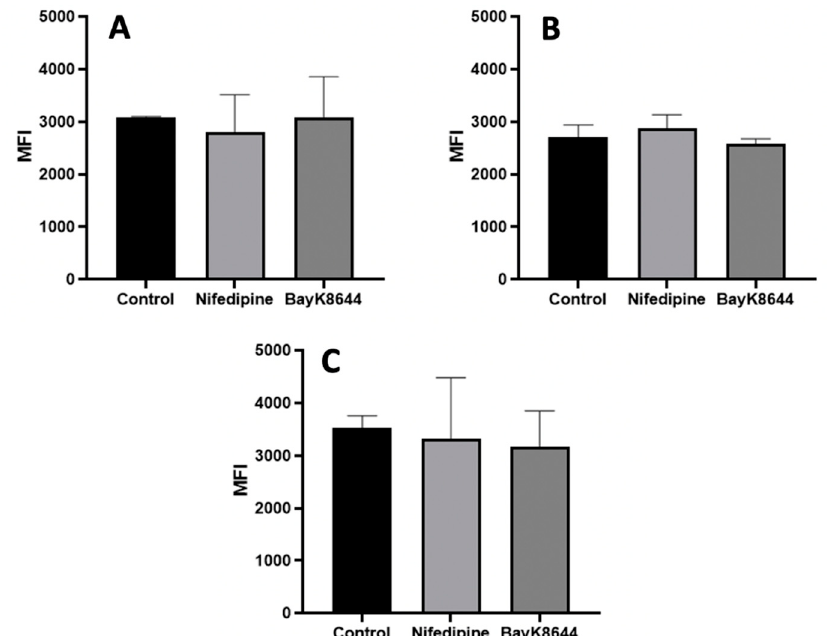
Figure 1. The effects of nifedipine and BayK8644 on iCa 2+ level in MenSCs ( A ), BMMSCs ( B ) and chondrocytes ( C ) cultivated in a monolayer. Cells were affected with nifedipine (10 µ M) or BayK8644 (10 µ M) for the 3 days, stained with Cal-520, and mean fluorescence intensity (MFI) was measured by flow cytometer (BD FACSAria). Control–cells without nifedipine or BayK8644. Data are shown as mean ± SD, n = 3 di ff erent donor samples-derived cells of each type. The identi fi cation of iCa 2+ by fl uorescent dye Cal520 and microscope showed almost